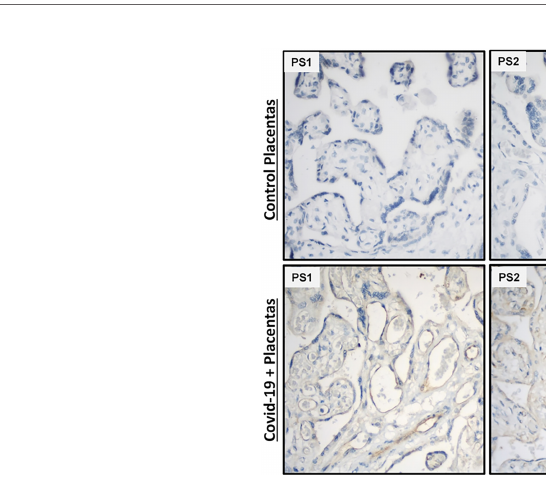
FIGURE 8 | SARS-CoV-2 spike protein immunostaining in placental villi from women tested positive for Covid-19. Endothelial cells and trophoblastic layers display strong to weak SARS-CoV-2 spike protein immunoreactivity in placental sections from COVID-19 infected mothers (n=3), but not in cells in placental sections from non-infected mothers (n=3). Inset picture represents negative control incubated with non-immune IgG 2a at the same monoclonal IgG 2a primary antibody concentration. PS, Placental specimen; Original magni fi cation: